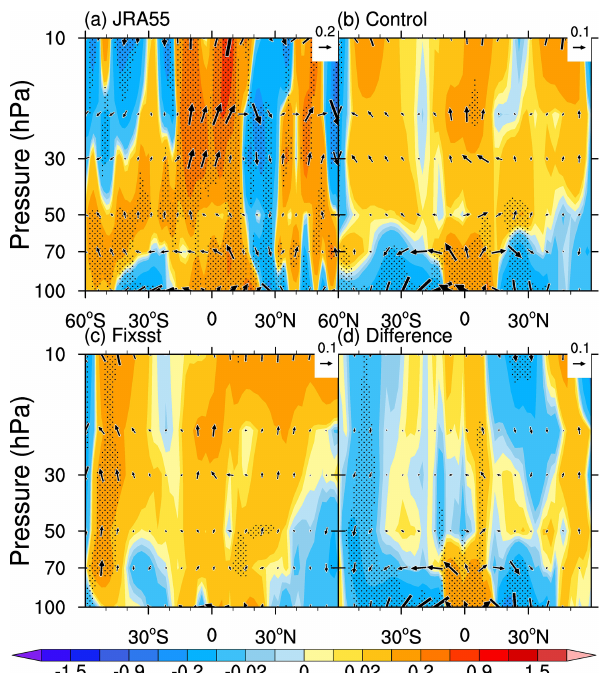
Figure 12. Trends of the BDC (vectors; the units in the horizon- tal and vertical components are 10 − 2 and 10 − 5 ms − 1 a − 1 , respec- tively) calculated using the TEM formula from (a) JRA55, (b) the Control simulation, (c) the Fixsst simulation, and (d) the differ- ence between the Control simulation and the Fixsst simulation in NDJFM during 1958–2017. The shadings are the trends of the w ∗ (10 − 5 ms − 1 a − 1 ). The trends of the vertical velocity over the dot- ted regions are statistically significant at the 90% confidence